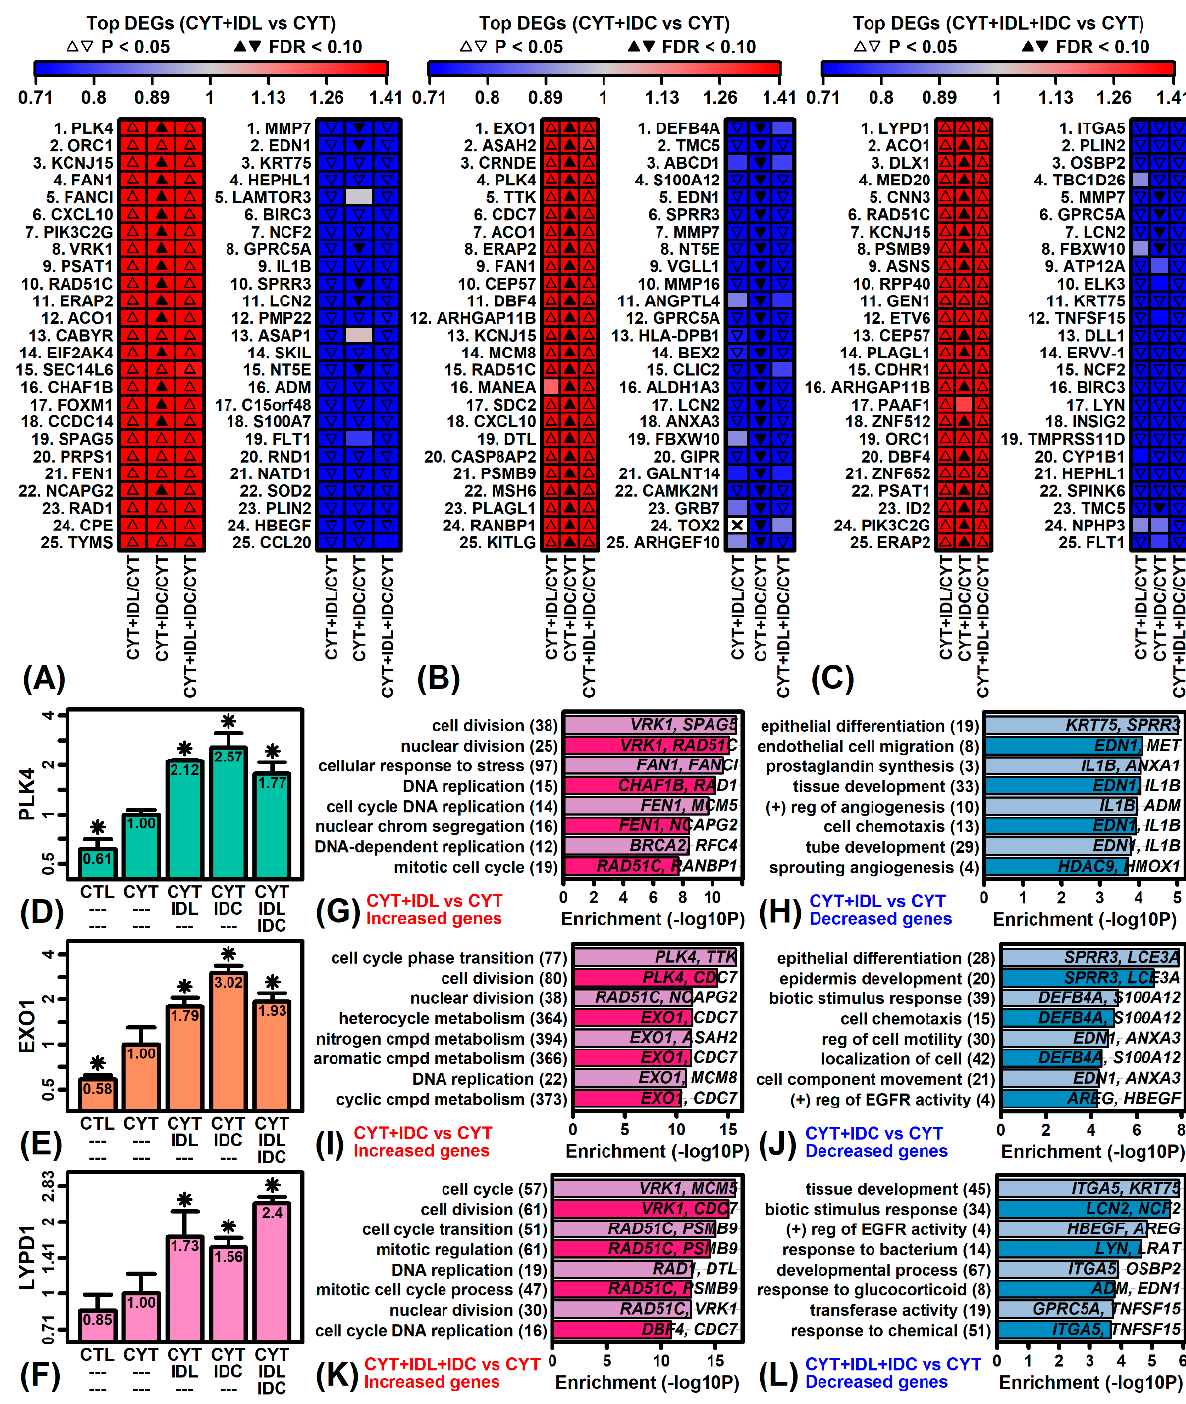
Figure 3. Gene expression responses to IDL, IDC and IDL + IDC in cytokine-stimulated RHE tissue. ( A – C ) Top-ranked DEGs. Heatmaps show the top 25 increased and decreased DEGs for each comparison. ( D ) PLK4 . ( E ) EXO1 . ( F ) LYDP1 . In ( D – F ), average expression is shown for each treatment (* p < 0.05, moderated t -test, comparison to CYT). ( G – L ) GO BP terms. Figures show Gene Ontology (GO) biological process (BP) terms most strongly enriched among DEGs with altered expression in each comparison ( p < 0.05, FC > 1.50 or FC < 0.67). The degree of enrichment is shown on the horizontal axis (i.e., − log10-transformed p -value). The number of DEGs associated with each GO BP term is given in parentheses. Example DEGs associated with each term are listed within figures. Genes most strongly increased by IDC included exonuclease 1 ( EXO1 ), N-acylsphin- gosine amidohydrolase 2 ( ASAH2 ), and colorectal neoplasia differentially expressed ( CRNDE ) (Figure 3B,E) and such genes were most strongly associated with cell cycle phase transition, cell division and nuclear division (Figure 3I). Genes most strongly de- creased by IDC included defensin beta 4A ( DEFB4A ), transmembrane channel like 5 ( TMC5 ), and ATP binding cassette subfamily D member 1 ( ABCD1 ) (Figure 3B) and such genes were most strongly associated with epithelial differentiation, epidermis develop- ment, and response to biotic stimulus (Figure 3J).